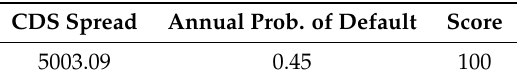
Table 5. Greece’s complexity